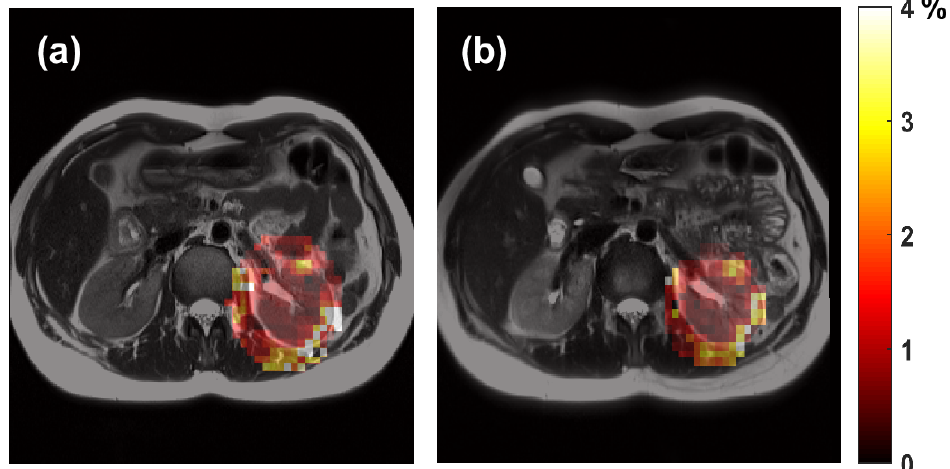
Figure 1. Representative data from: ( a ) the baseline; ( b ) repeated scans. The kidney hilum was used as an anatomical marker to acquire data from the same axial slice. The color-coded area is the coregistered MRSI fat-fraction map (masked about the left kidney) overlaid over its corresponding structural MRI image.